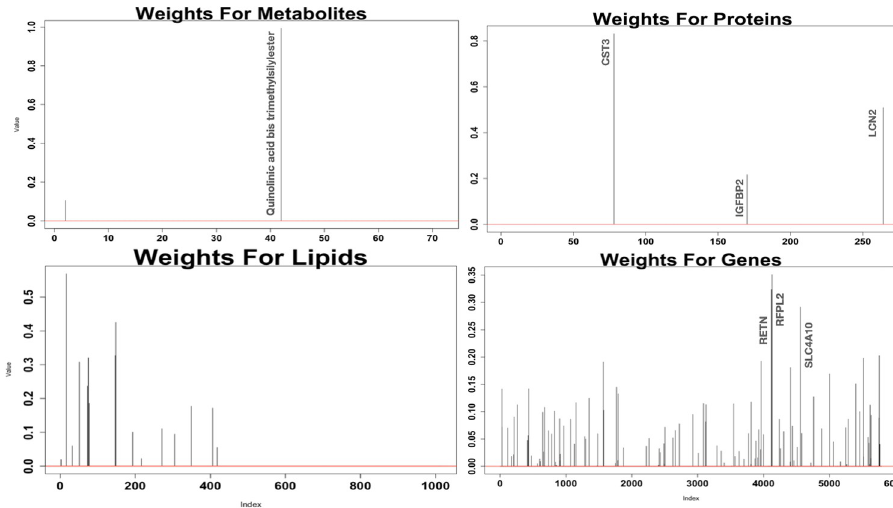
Fig 13. Absolute coefficients for second component of smCCA. These plots contain the absolute values of the weights for each datasets’ second component in